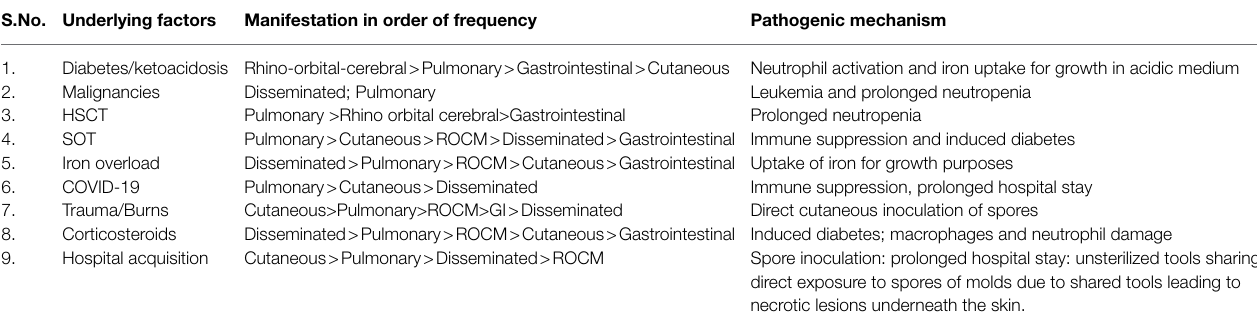
TABLE 1 | Clinical manifestations and pathogenic mechanisms of underlying